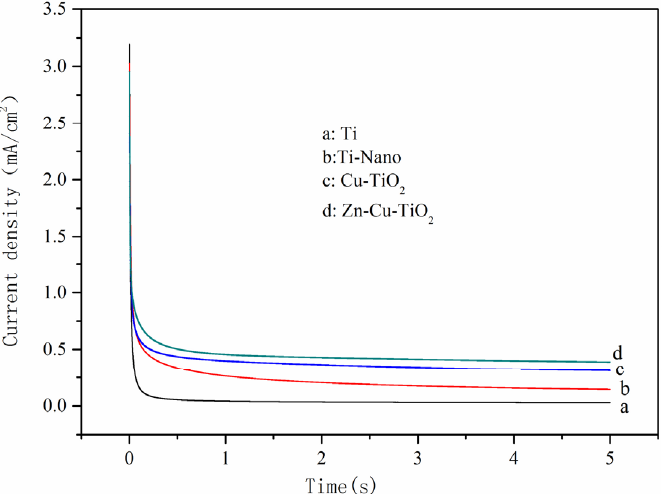
Figure 6. Current density vs. time for the different electrodes.